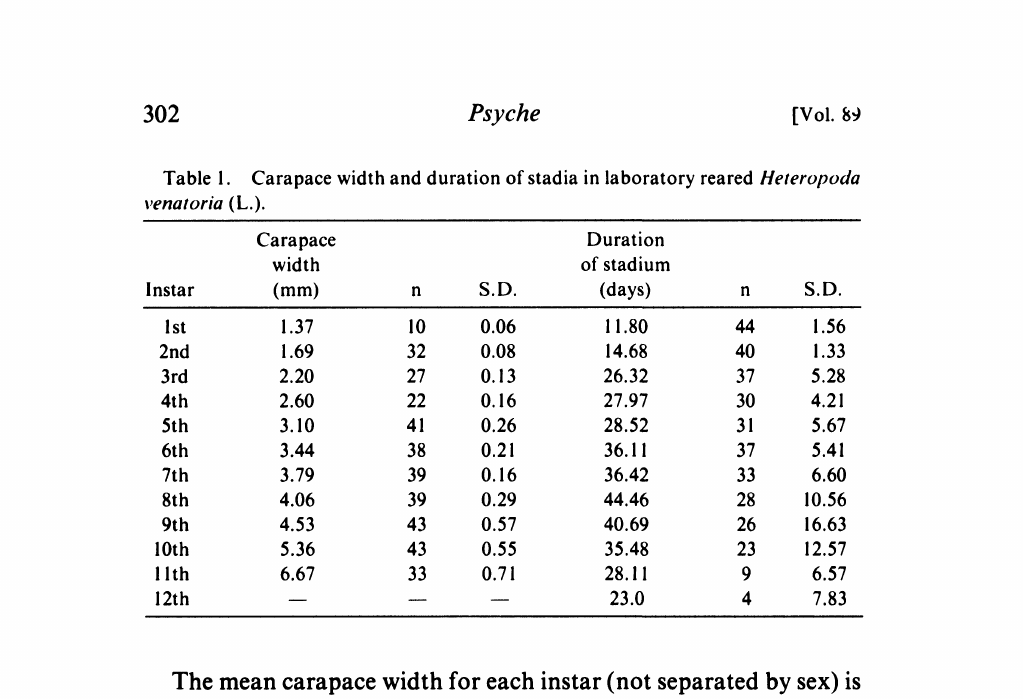
Table 1. Carapace width and duration of stadia in laboratory reared Heteropoda venatoria